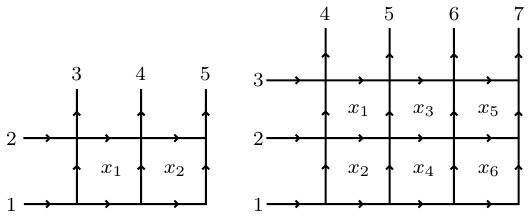
Figure 13 . Two examples for web graphs, Web 2 ; 5 on the left and Web 3 ; 7 on the